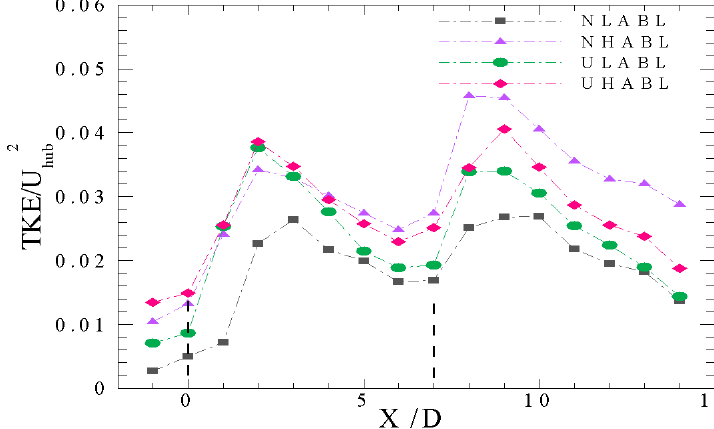
Figure 9. TKE at blade tip at maximum height (Z/D = 1.21).